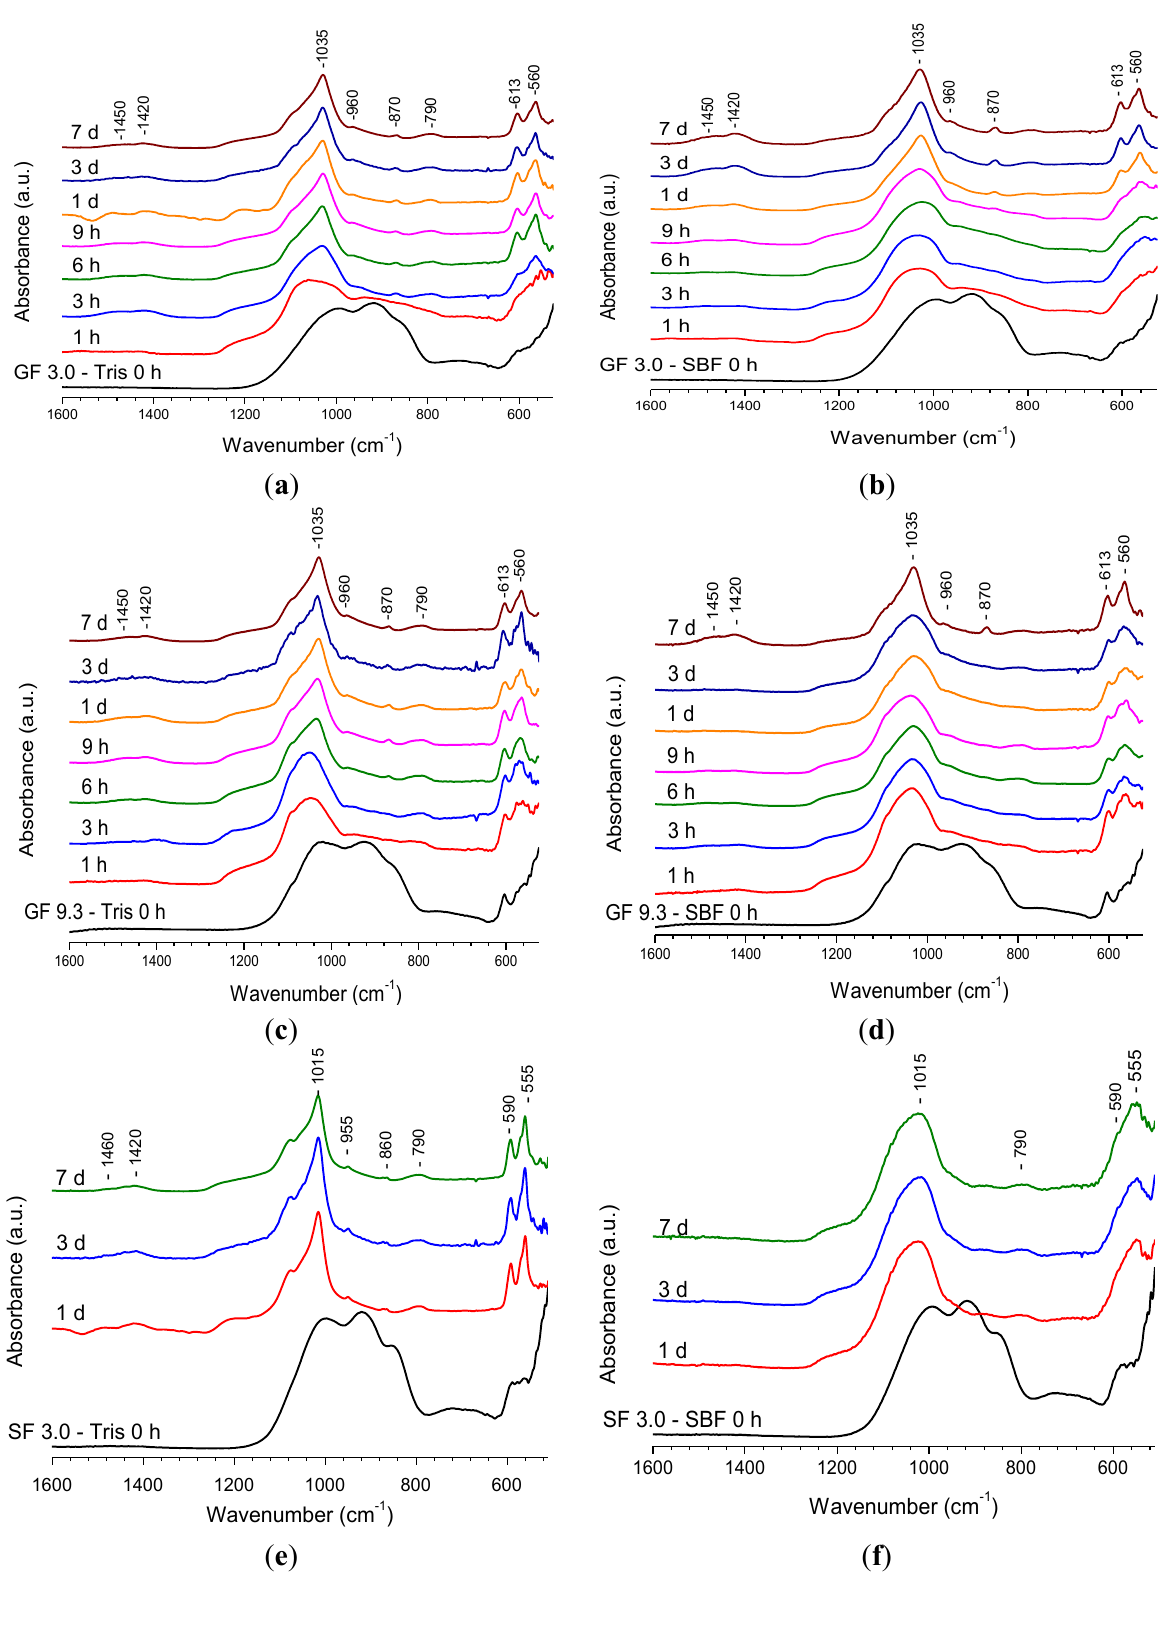
Figure 2. FTIR spectra of glasses after immersion in buffer solutions: ( a ) GF 3.0 in Tris; ( b ) GF 3.0 in SBF; ( c ) GF 9.3 in Tris; ( d ) GF 9.3 in SBF; ( e ) SF 3.0 in Tris; ( f ) SF 3.0 in SBF; ( g ) SF 9.3 in Tris; ( h ) SF 9.3 in